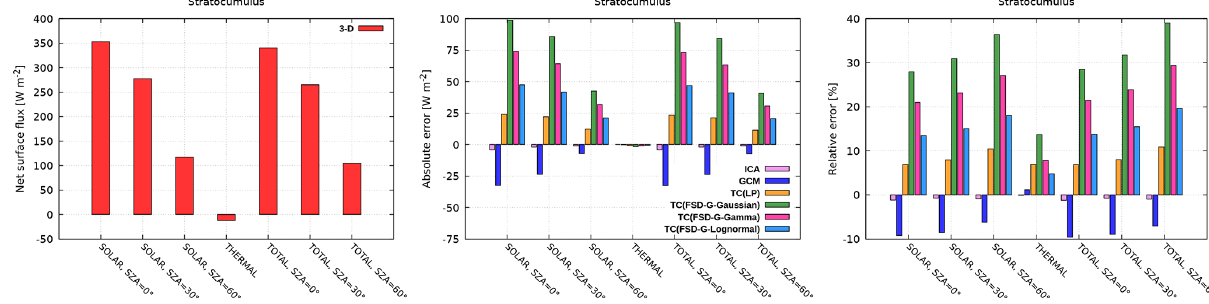
Figure 6. Net surface radiative flux for stratocumulus.